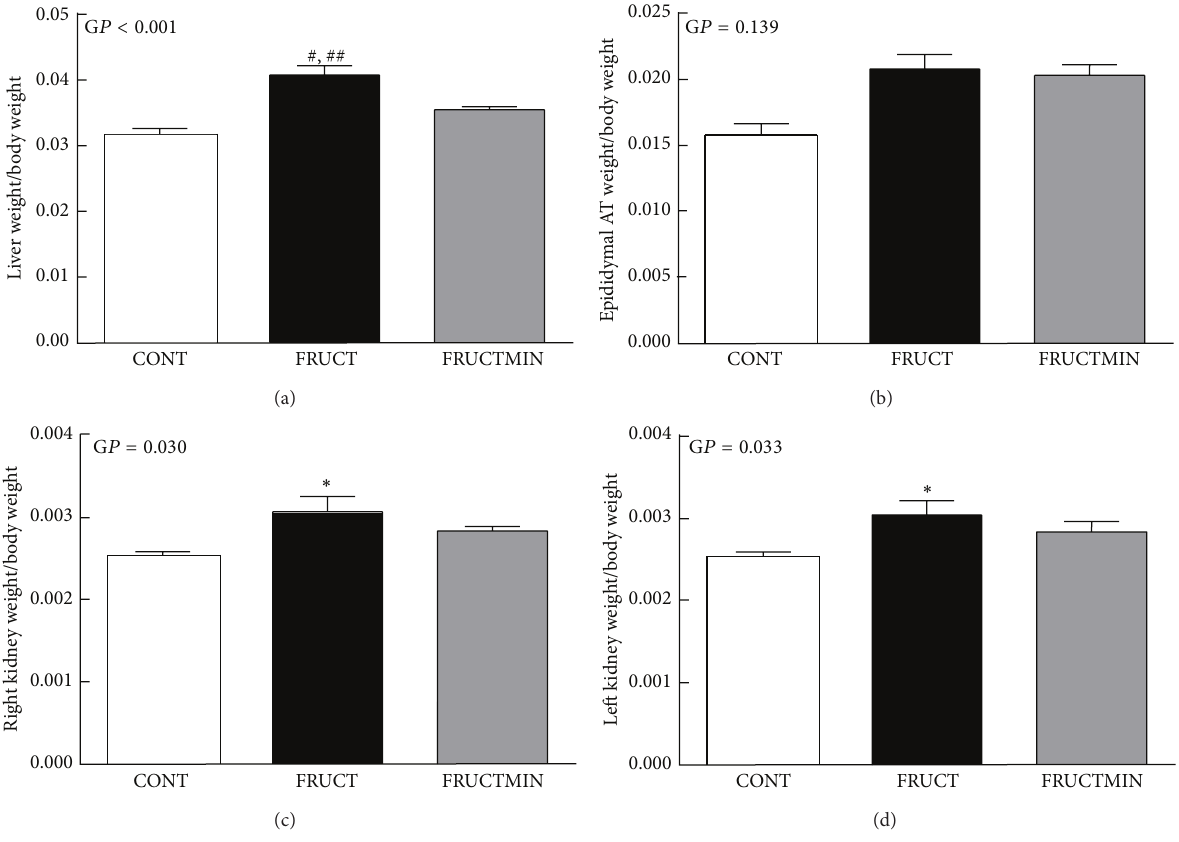
Figure 5: Organ weight to body weight ratios. (a) Liver ( 𝑛 = 7 ), (b) epididymal adipose tissue ( 𝑛 = 7 ), (c) right kidney ( 𝑛 = 6 -7), and (d) left kidney ( 𝑛 = 6 -7), at the end of the dietary intervention. Results were expressed as mean ± standard error of the mean. # 𝑃 < 0.001 CONT versus FRUCT, ## 𝑃 < 0.005 FRUCT versus FRUCTMIN, and ∗ 𝑃 < 0.05 CONT versus FRUCT. AT: adipose tissue; CONT: control; FRUCT: 10% fructose in tap water; FRUCTMIN: 10% fructose in natural mineral-rich water; G 𝑃 : global P